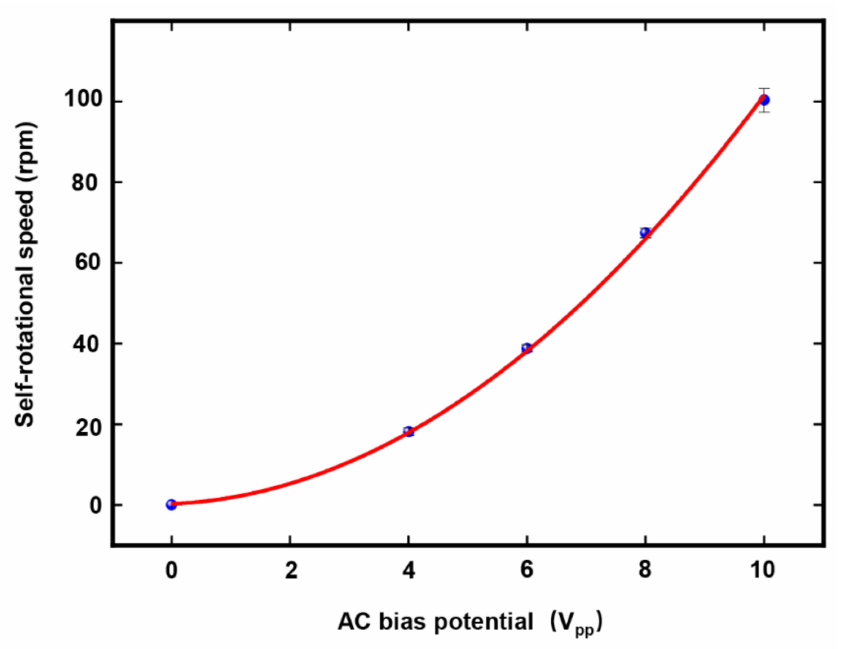
Figure 15. Self-rotational speeds of Raji cells with different AC bias potentials at an external AC frequency of 60 kHz. The measurement points in this figure were obtained for one Raji cell only. At each measurement point, the period of stable continuous rotation of the cell was selected for measurement, and the number of rotation periods for the applied AC bias potential of {4, 6, 8, 10} VPP was {1, 2, 3, 5}, respectively. In the figure, each data point represents a mean ± maximum